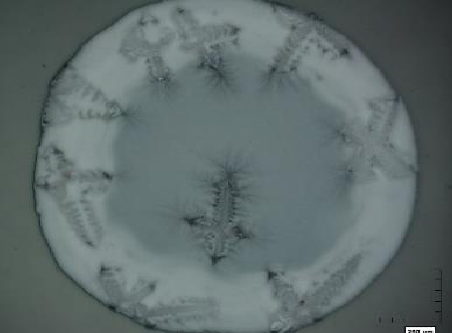
Figure 3—Alumina drop on PET. The bar shown is 250 µm. Initial concentration of alumina is 0.40 weight fraction.